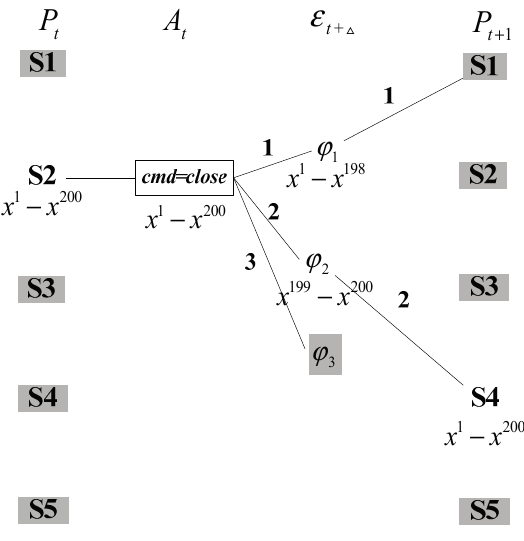
Figure 3. Simple one-step belief state